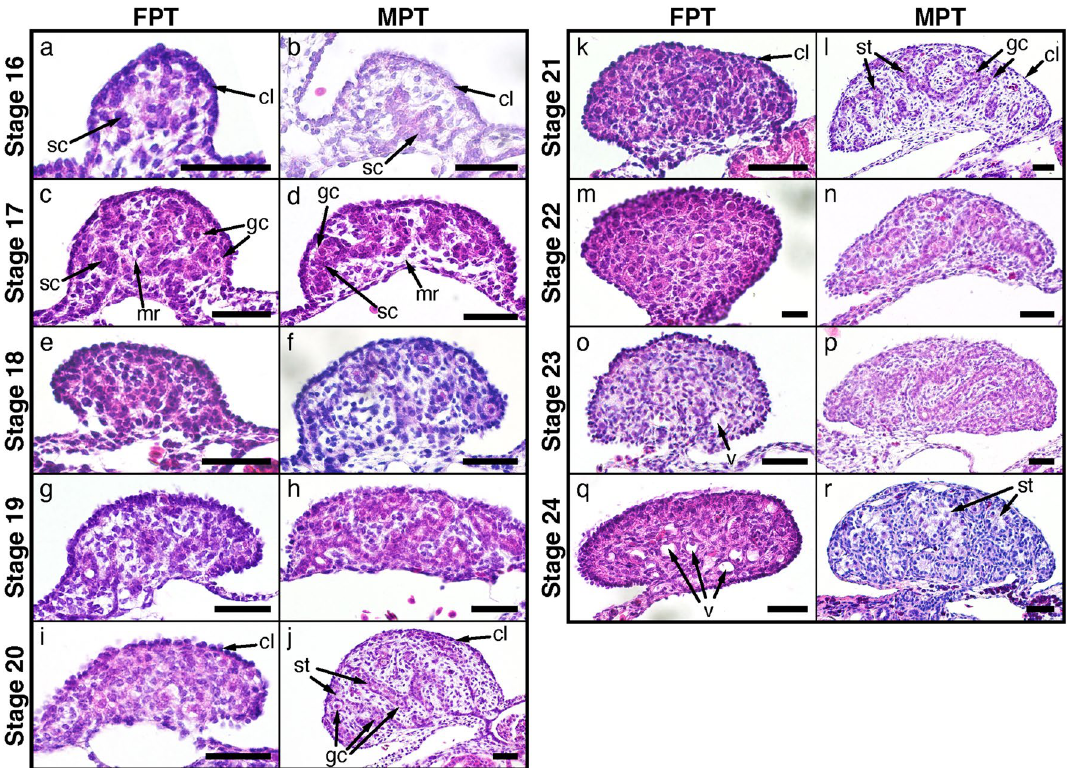
Stage 17, FPT (n = 4). ( d ) Stage 17, MPT (n = 3). ( e ) Stage 18, FPT (n = 3). ( f ) Stage 18, MPT (n = 3). ( g ) Stage 19, FPT (n = 5). ( h ) Stage 19, MPT (n = 3). ( i ) Stage 20, FPT (n = 2). ( j ) Stage 20, MPT (n = 4). ( k ) Stage 21, FPT (n = 3). ( l ) Stage 21, MPT (n = 4). ( m ) Stage 22, FPT (n = 7). ( n ) Stage 22, MPT (n = 5). ( o ) Stage 23, FPT (n = 3). ( p ) Stage 23, MPT (n = 3). ( q ) Stage 24, FPT (n = 4). ( r ) Stage 24, MPT (n = 4). sc, sex cord; cl, cortical layer; mr, medullary region; gc, germ cell; st, seminiferous tubule; v, vacuolated area. The scale bar is 50